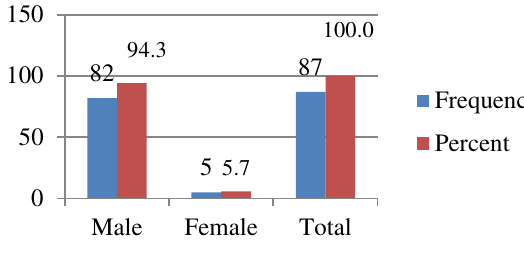
Fig. 1. Gender of participants